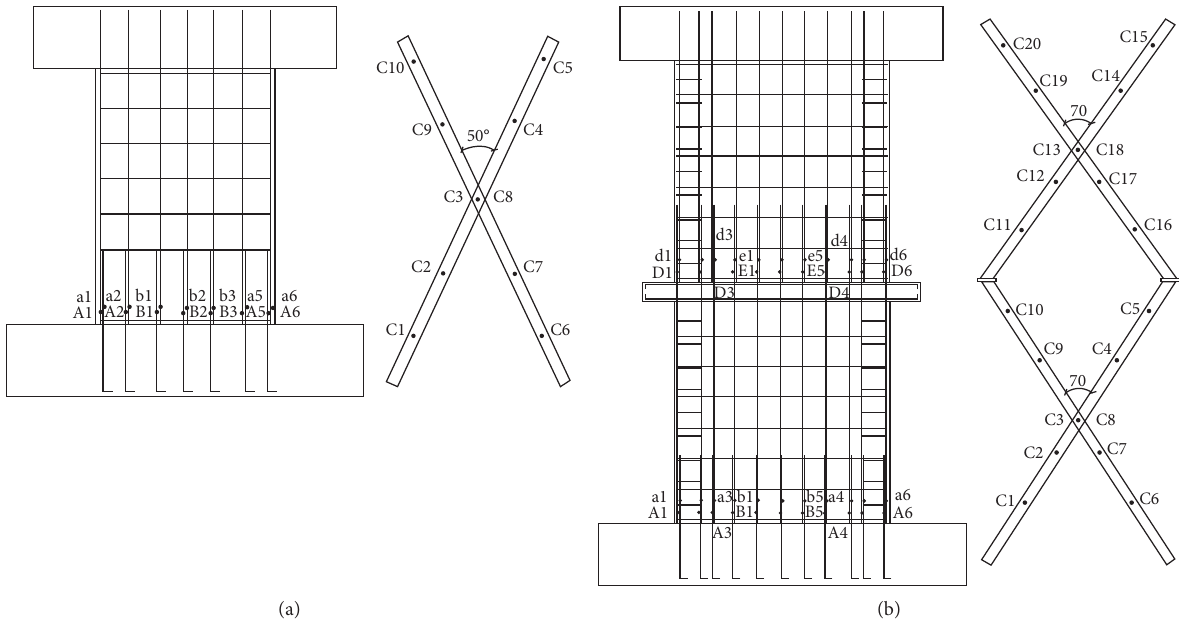
Figure 6: Arrangement of strain gauges. (a) Group 1. (b) Group 2.